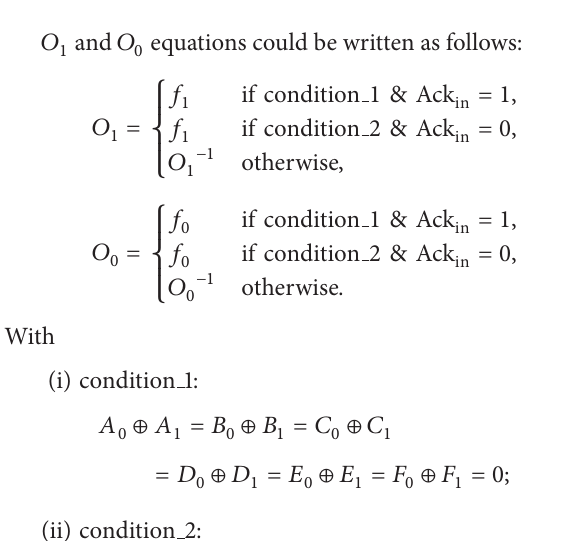
Figure 13: Detailed inputs of the LUT6.